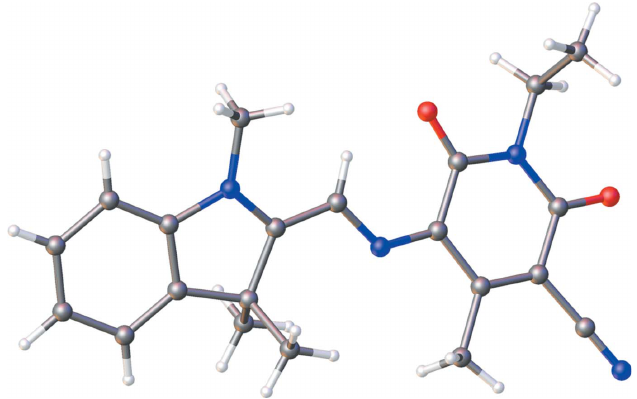
Figure 4 The moleculular structure of a compound with a similar structure to DTB (PAQYEM; Song et al. ,